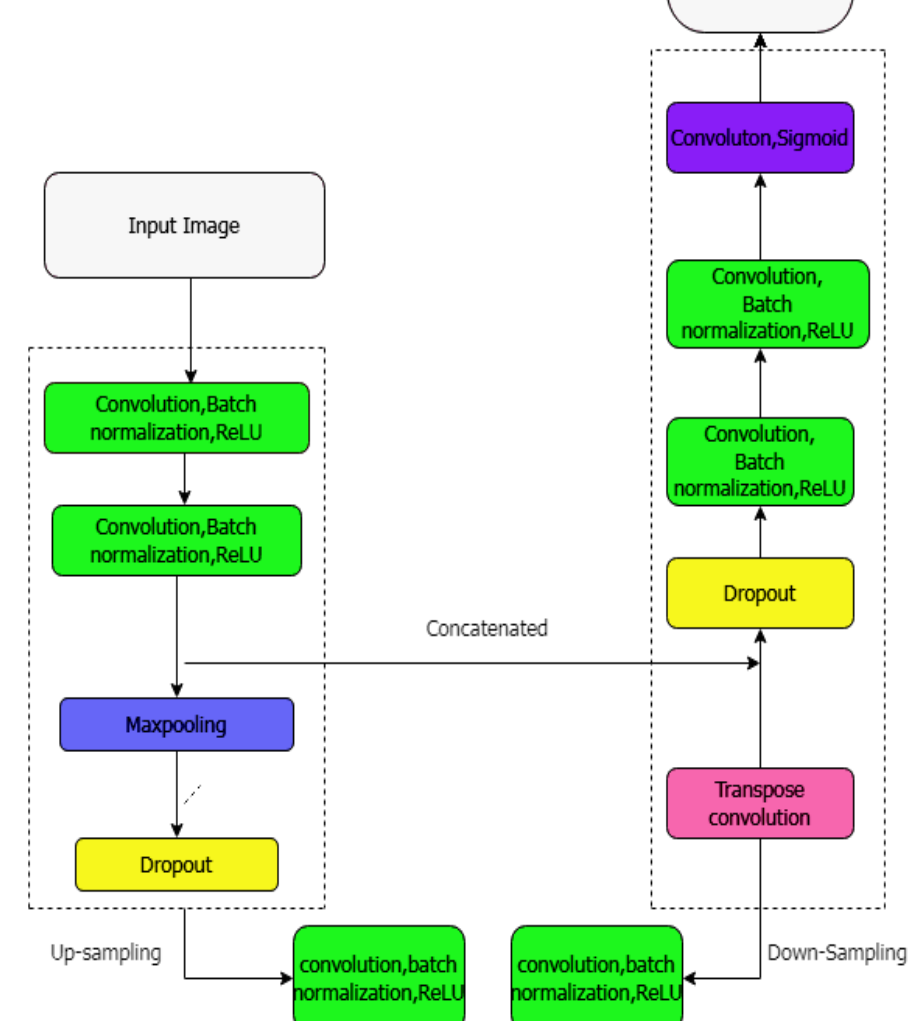
Figure 14. The architecture of adding batch-normalization and dropout layer in up-sampling and down-sampling processes.